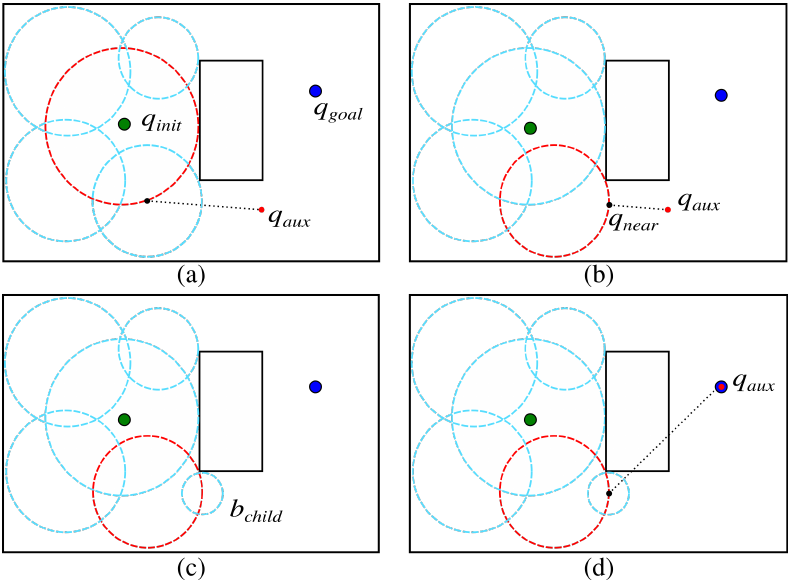
Figure 5. GBPF propagation from initial (green dot) to goal configuration (blue dot). ( a ) q aux (red dot) is sampled and the nearest parent bubble is selected. ( b ) The configuration q near is selected. ( c ) A new bubble on q near is expanded. ( d ) The configuration q aux is sampled on the q goal